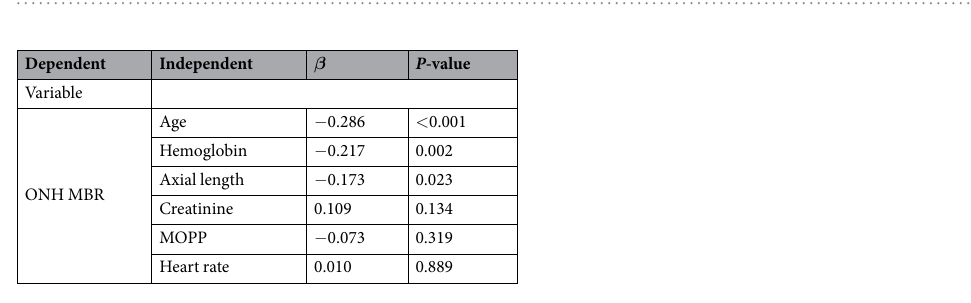
Table 6. Result of multiple stepwise regression analysis for independence of factors including laboratory data contributing to ONH MBR in the female group. ONH: optic nerve head; MBR: mean blur rate; MOPP: mean ocular perfusion